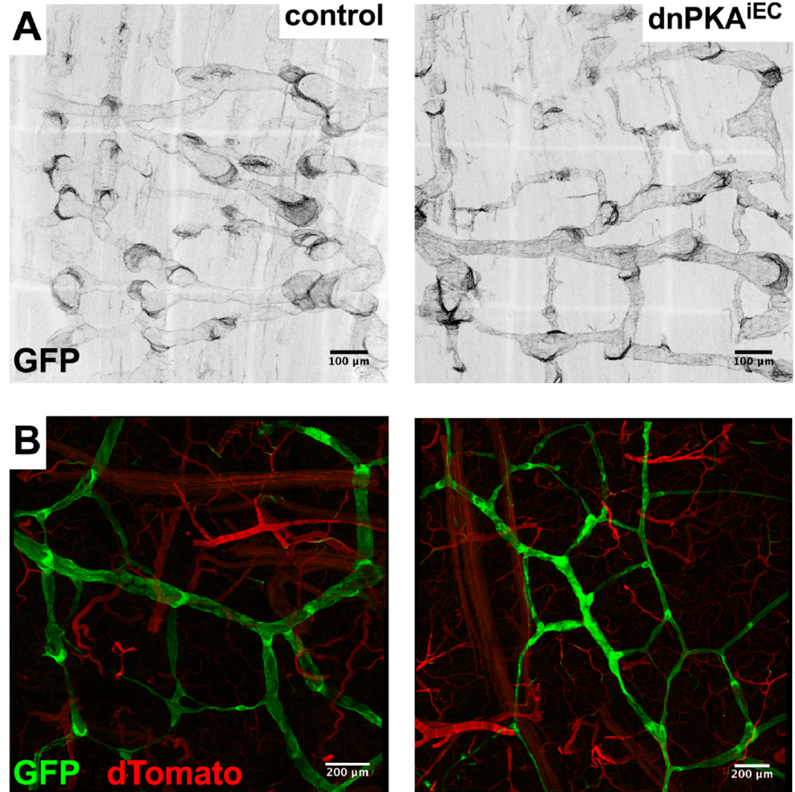
Figure 4. Expression of dnPKA in lymphatic endothelial cells does not induce changes in lymphatic morphology. dnPKA expression in lymphatic endothelial cells was induced by Vegfr3-CreERT2 (ta- moxifen injections at postnatal days 1 to 3). Successful recombination in the lymphatics of diaphragm ( A ) and ventral skin ( B ) were monitored by GFP expression from the mT/mG reporter. Expression of dnPKA in lymphatic endothelial cells only did not induce any changes in the density or morphology of lymphatic vessels. Scale bar, 100 µ m in ( A ) and 200 µ m in ( B ). Control (Vegfr3-CreER T2 carrying mT/mG transgene) and mutant (carrying Vegfr3-CreER T2 , Prkar1a tm2Gsm , and mT/mG alleles) mice were injected with tamoxifen at the age of 1–3 days; shown are tissues and staining of 74-day-old female